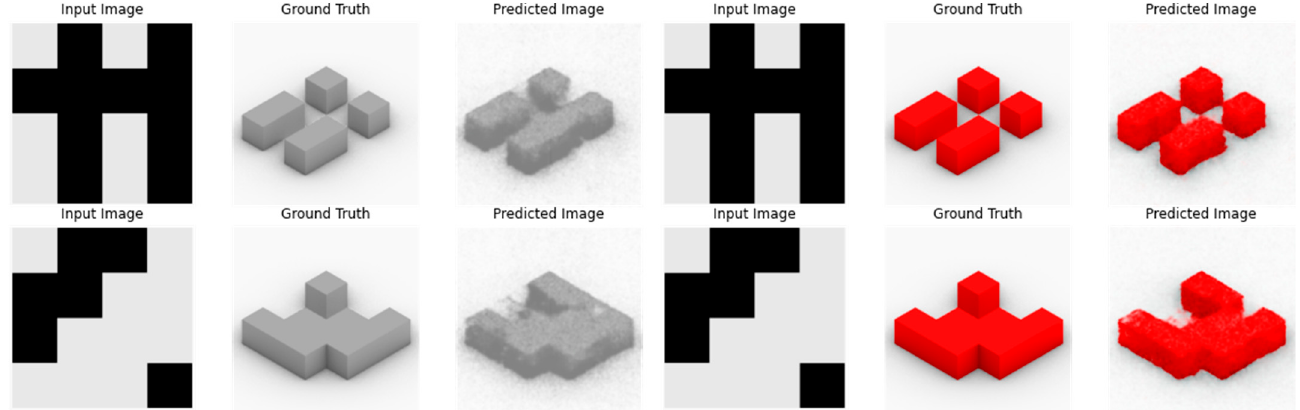
Figure 5. Outputs from A01 (gray) and A02 (red) Examples of the output generated by the first test. From left to right: pattern, expected result and generated image. Red isometrics better represent the “ground truth.”